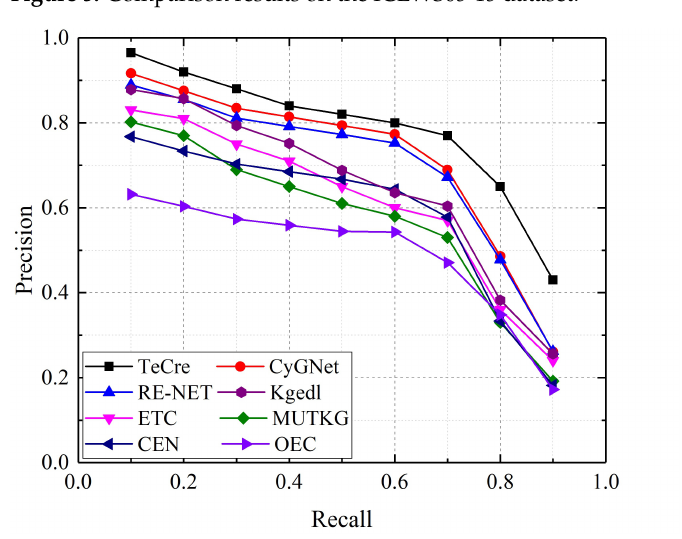
Figure 6. Comparison results on the WIKIDATA dataset.